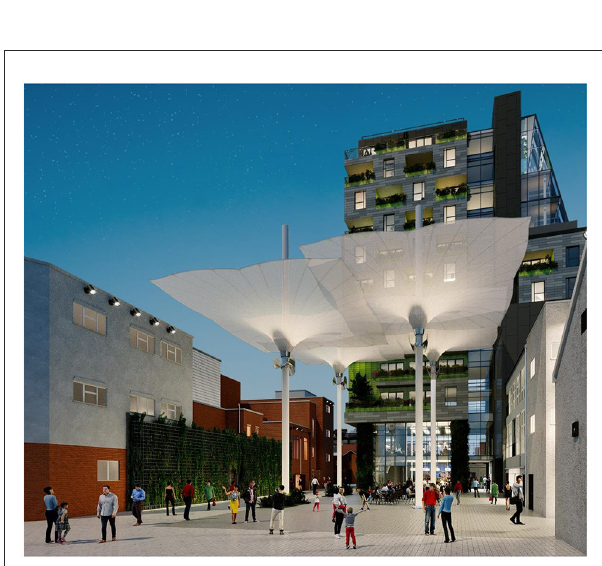
FIGURE2 Proposed outdoor public area. Image used in focus group presentations and reproduced with kind permission from the